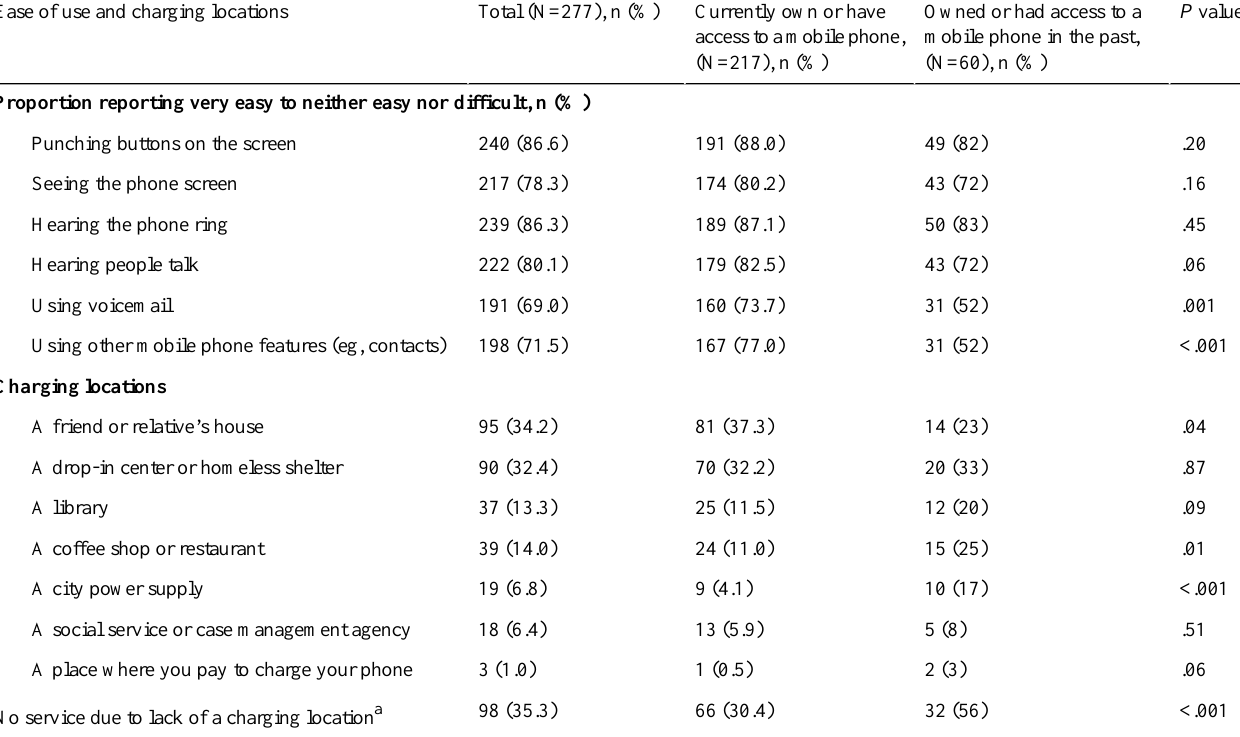
P valueOwned or had access to a